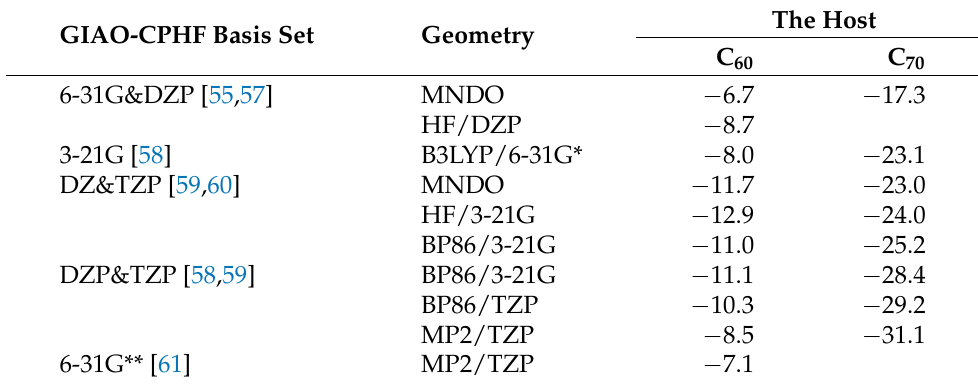
Table 1. The dependence of the computed 3 He chemical shifts [ppm] in the He@C 60 and He@C 70 endohedral complexes on the level of theory ( a )